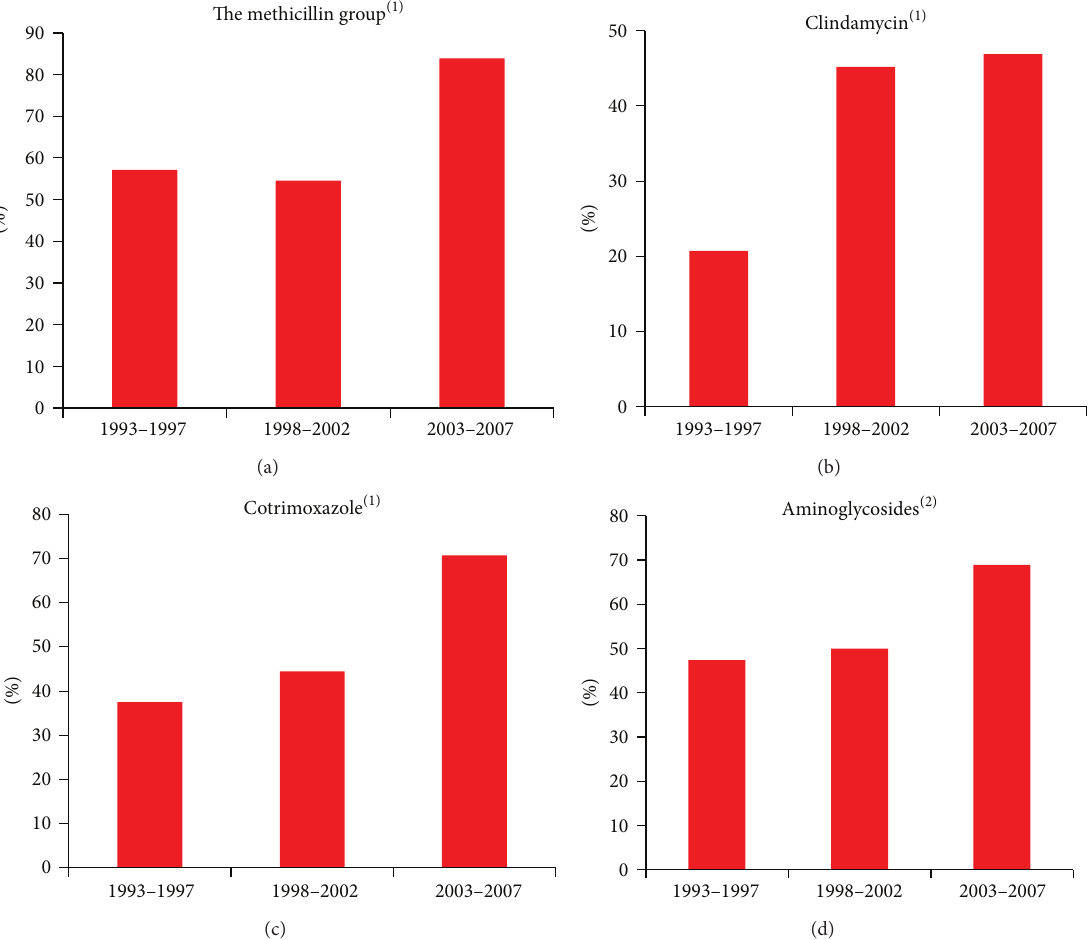
Figure 2: Development of resistance in coagulase-negative staphylococci towards selected antibiotics. Percent resistance is present on the 𝑦 -axis, time period on the 𝑥 -axis. (1) Significant increase in resistance for methicillin, clindamycin, and cotrimoxazole ( 𝑃 < 0.05). (2) Not significant increase in resistance for aminoglycosides ( 𝑃 =